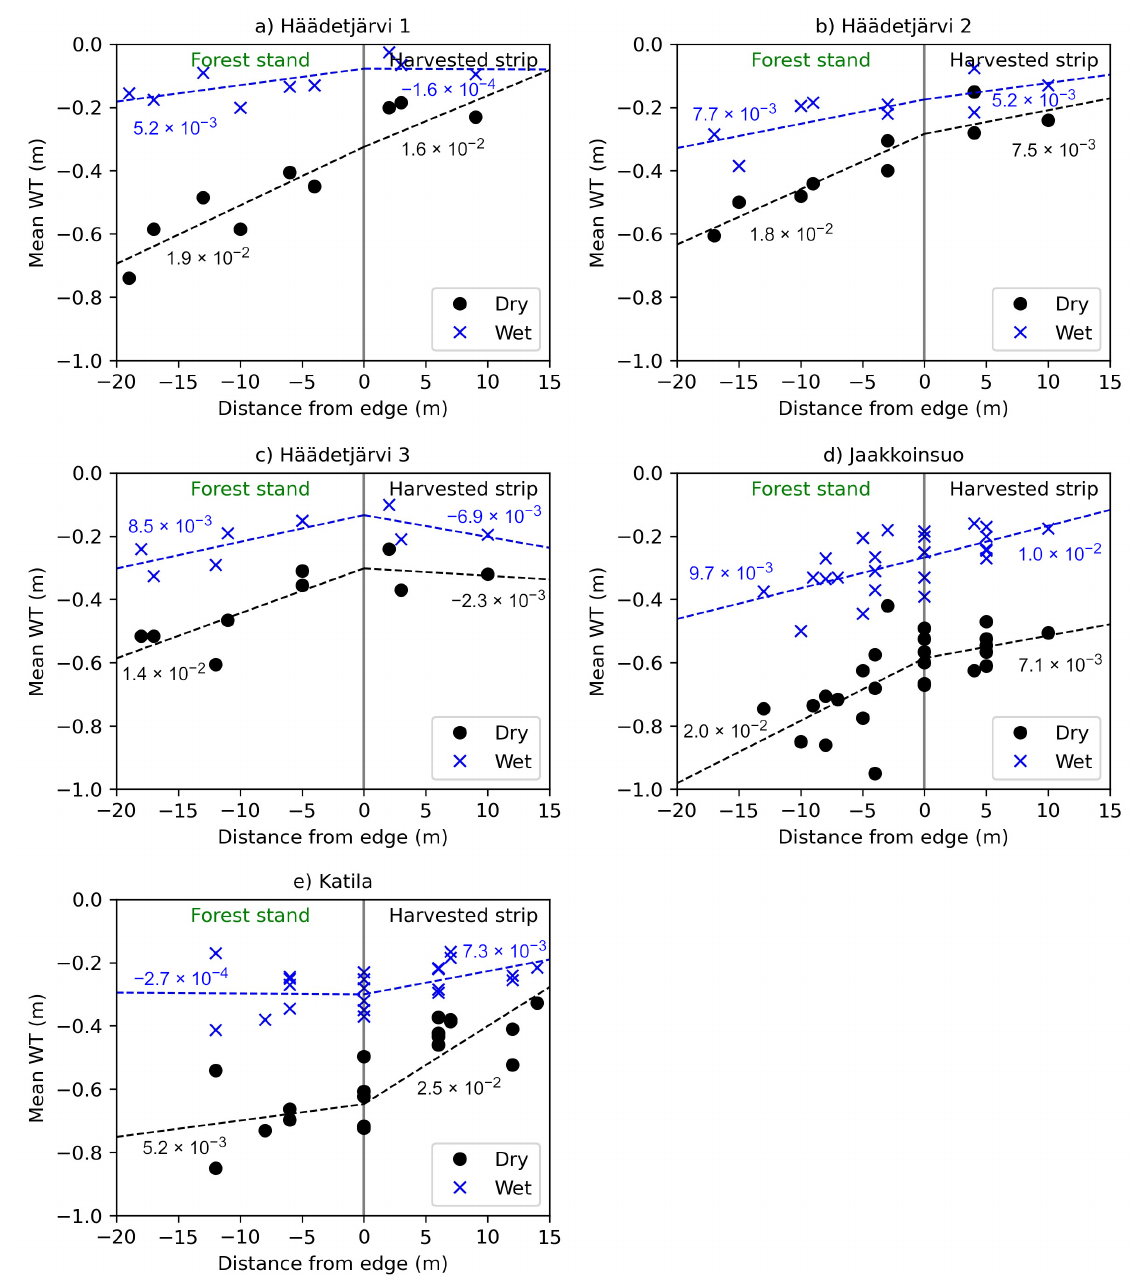
Figure 3. The mean measured WTs in August 2017 (wet, i.e., rainy and cool growing season) and 2018 (dry and warm growing season) at the study sites ( a – e ) in southern Finland according to the WT tube’s location from the edge of the unharvested forest stand and harvested (treeless) strip. Dashed lines present a piecewise linear function (WT–WT edge = ax, where x is the distance from the edge; WT edge is the mean WT at the edge or the nearest points) fitted to the data separately for the forest and harvested strips. The numbers next to the dashed lines represent the slopes of the fitted lines.